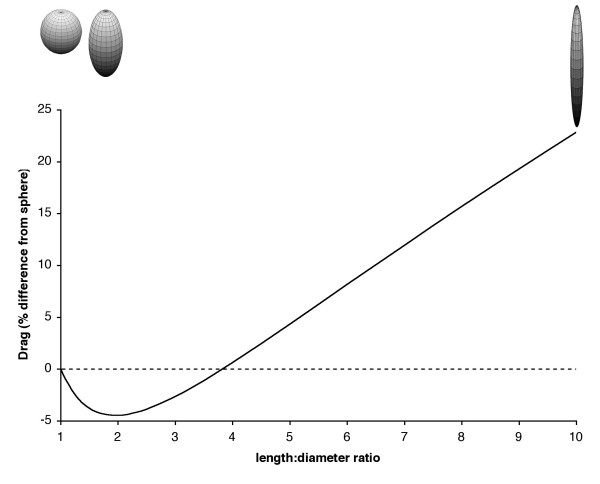
Percentage difference in drag between a sphere and a prolate spheroid of identical volume at Re << 1. As the ratio of length to diameter of the spheroid increases (i.e. the shape elongates) there is an initial decrease in drag, but this difference only results in drag for the spheroid dropping to a minimum of 95.66% of that of the sphere.